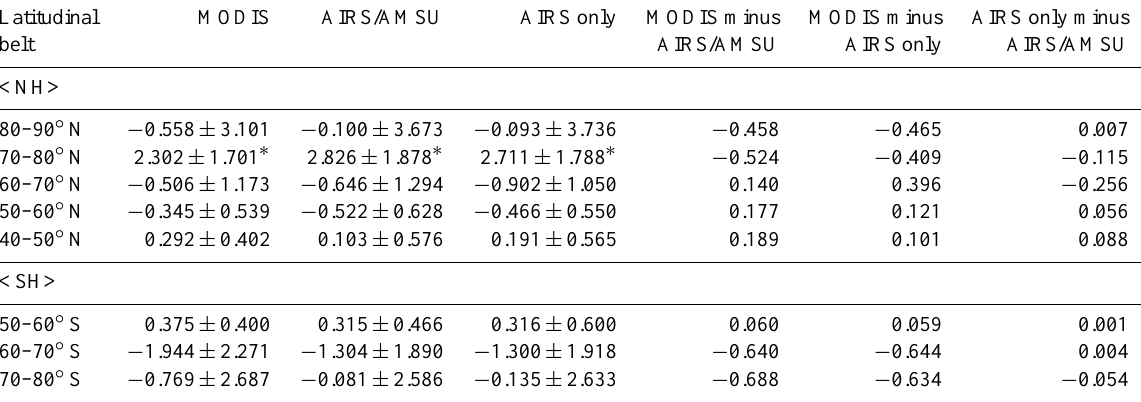
Table 3. The rate of the surface skin temperature change (Kdecade − 1 ) of the MODIS, AIRS/AMSU, and AIRS only in each 10 ◦ latitudinal belt over the Northern Hemisphere (NH) during 16–24 April and over the Southern Hemisphere (SH) during 15–23 September 2003–2014, using their colocated data in a 1 ◦ × 1 ◦ grid. The ± values define the 95% confidence intervals for the trends. The symbol “ ∗ ” means the significant value at a 95% confidence interval. Note that the rates are subject to large uncertainty due to the short periods of the satellite- based temperature records. Latitudinal MODIS AIRS/AMSU AIRS only MODIS minus MODIS minus AIRS only minus AIRS/AMSU AIRS only